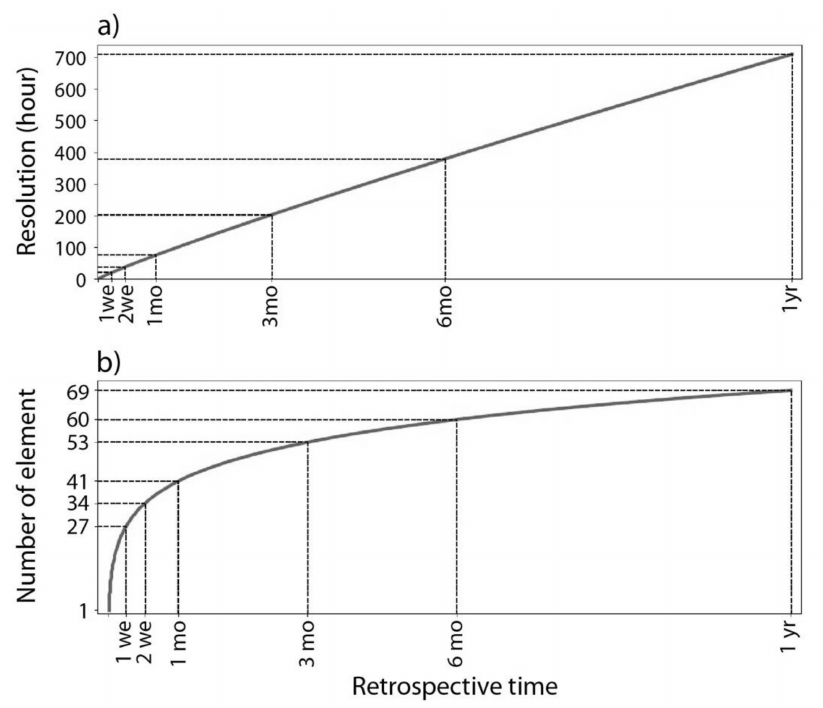
Figure 3. Time resolution ( a ) and number of sample elements ( b ) of input precipitation data. The abscissa is the time to which the precipitation time series goes back from the current time. “we”, “mo”, and “yr” denote weeks, months, and years,